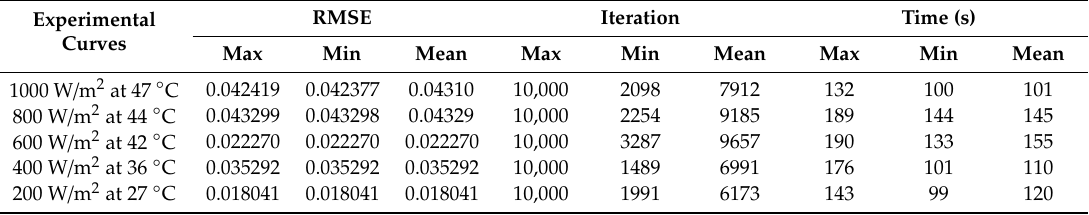
Table 17. Statistical results for the double-diode JKM330P-72, 310 W polycrystalline PV